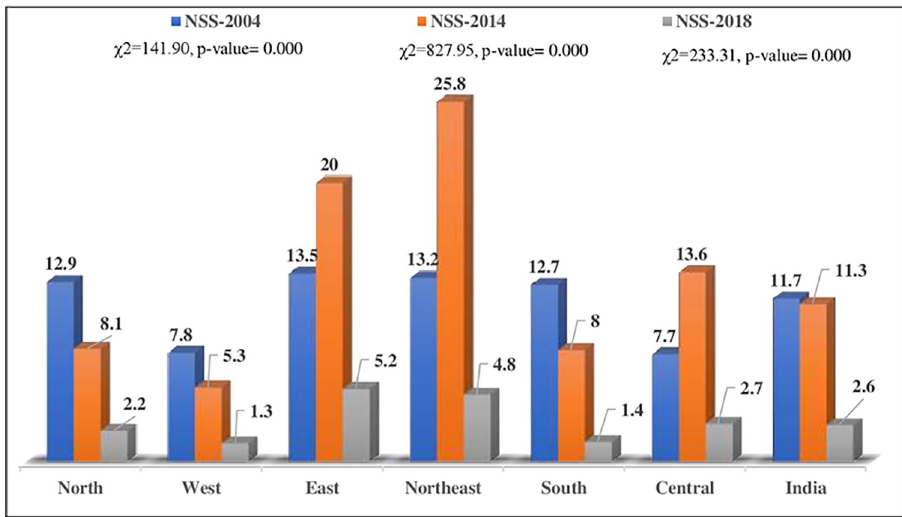
Fig 2. Unmet need for treatment-seeking among those who suffered/are suffering from any disease by region of residence in India, NSS,